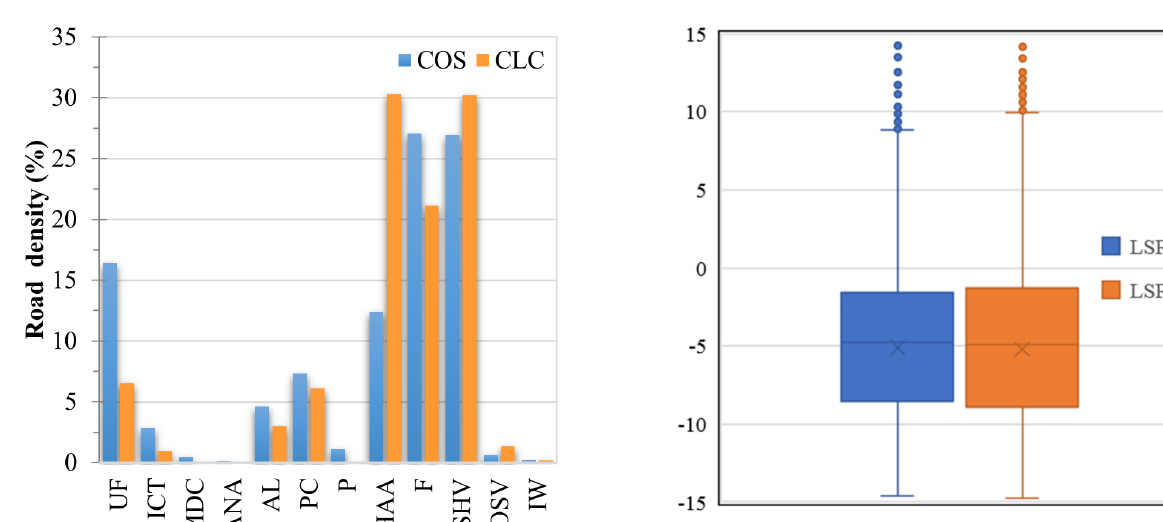
Figure 8. Landslide susceptibility of the road network. LSRN1 – IV assigned for LSM1; LSRN2 – IV assigned for